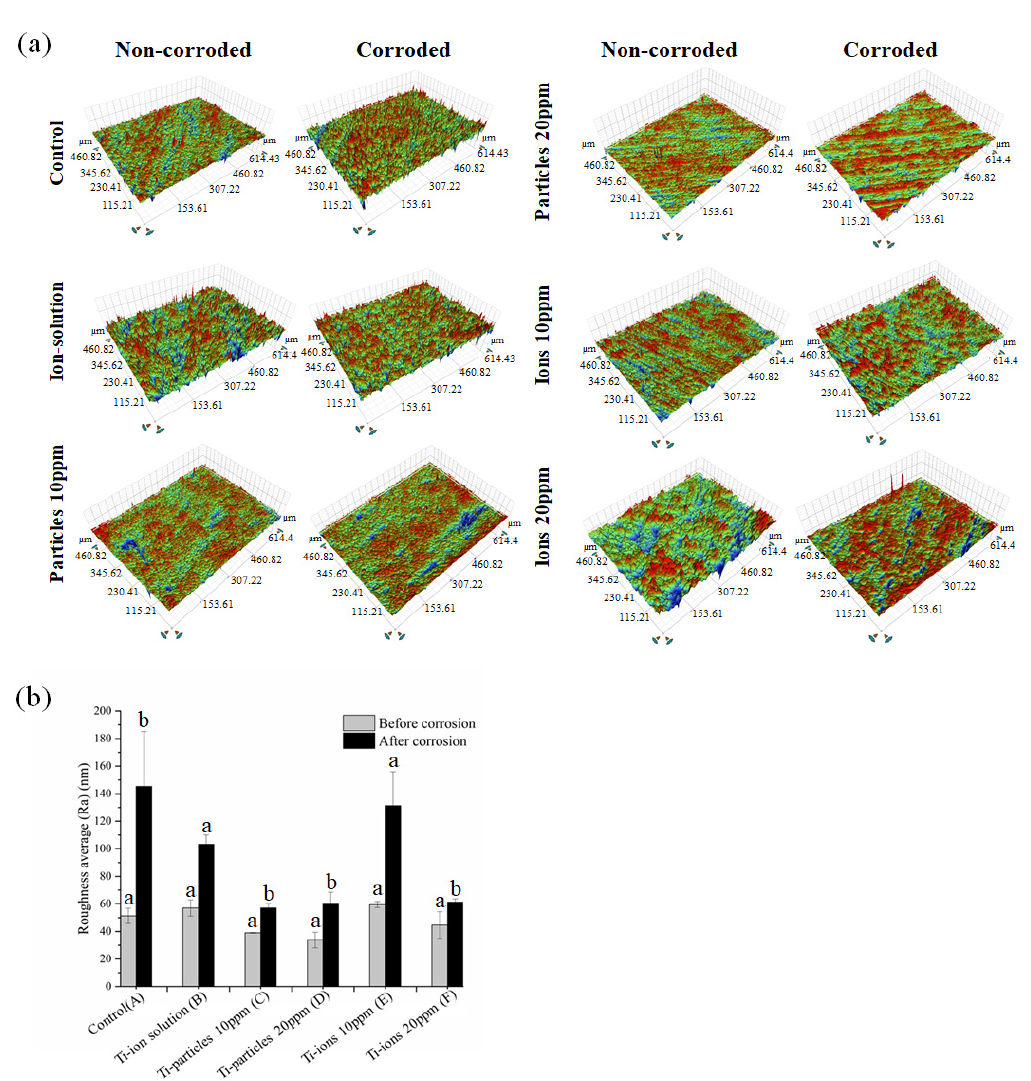
Figure 6. ( a ) White light 3D images of representative Ti samples. The non-corroded areas are shown in images in the left column and the corroded areas of the same samples are shown in the right column. ( b ) Mean and standard deviation of the surface roughness (Ra).